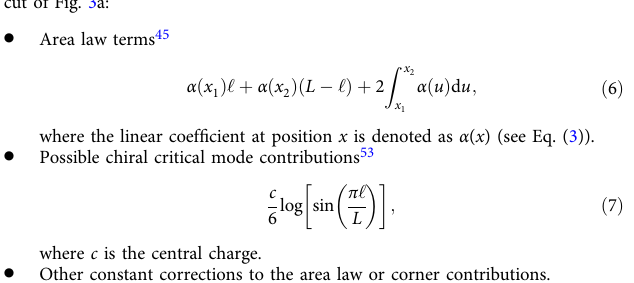
Fig. 3 Chiral interface edge mode: a Levin – Wen subtraction scheme to get rid of the spurious area law coming from the patch boundaries along the cylinder perimeter together with corner contributions to the EE. The position and width w of the rectangular extension are selected to fully include the gapless mode at the interface. The critical EE coming from the ‘; w Þ for different gapless mode at the interface is counted twice. b S A ð cylinder perimeters. They all fall on top of the CFT prediction Eq. (5) with c = 1 (black line), pointing toward a chiral Luttinger liquid at the interface. ‘; w Þ and its agreement with the The inset shows the derivative ∂ ‘ S A ð theoretical